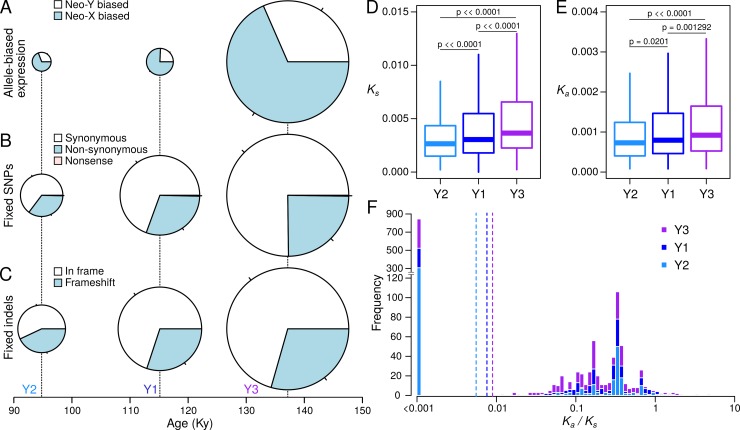
Extent of neo-Y degeneration is correlated with haplotype age.A. The proportion and number of genes with significant neo-X and neo-Y bias are plotted for each of the three haplotypes. B. Same as A, but with different classes of fixed and haplotype-specific SNPs found in CDS. C. Same as B, but with indels found in CDS. Size of pie charts are proportional to the total number of genes/mutations for each haplotype. D-E. Distribution of the rates of synonymous (Ks) and non-synonymous (Ka) fixed substitutions among the Y-types. F. Distribution of Ka/Ks ratios for each of the three Y-types in log scale. Dotted vertical lines demarcate the average ratio.